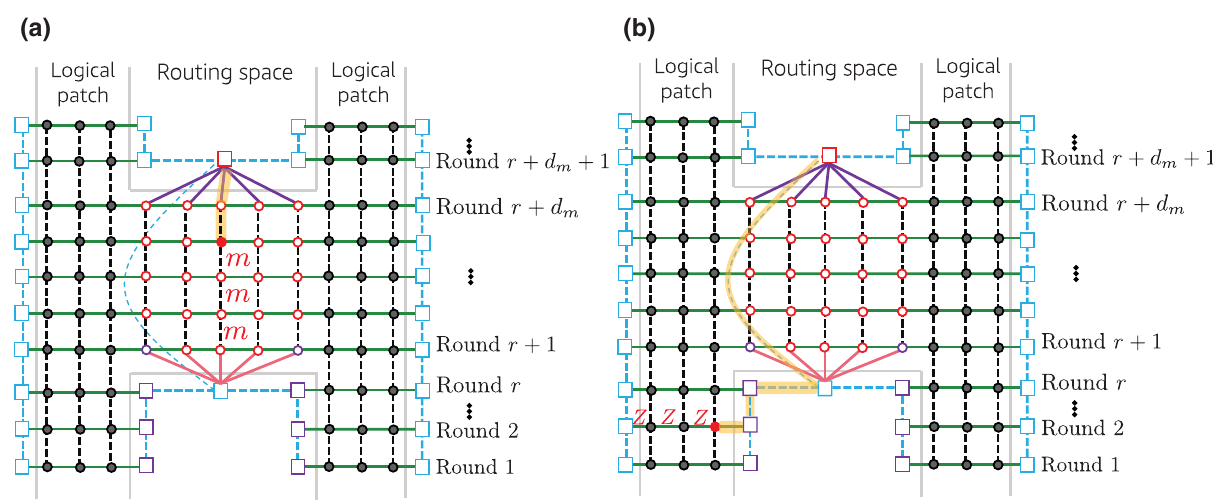
FIG. 7. (a) An example of a series of consecutive measurement errors on the same parity vertex located in the routing space resulting in a ( 0, 1, 0, 0 ) logical failure for an X ⊗ X measurement. (b) An example of a horizontal string of spacelike Z data-qubit errors on the left logical patch resulting in a ( 1, 1, 0, 0 ) logical